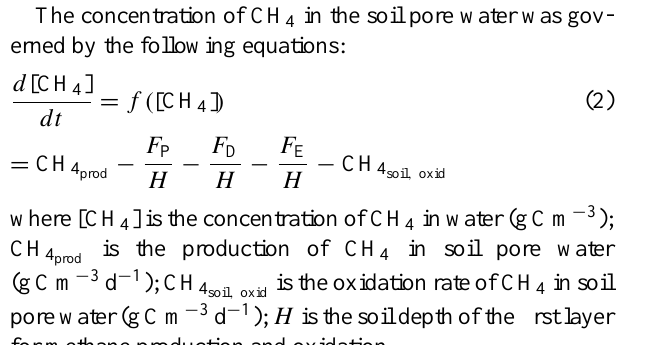
Fig. 2. Modules of CH 4 and N 2 O in the Dynamic Land Ecosys- tem Model (DLEM) (CH 4 production, oxidation, and transport are considered in the CH 4 module; nitrification and denitrification are considered in the N 2 O